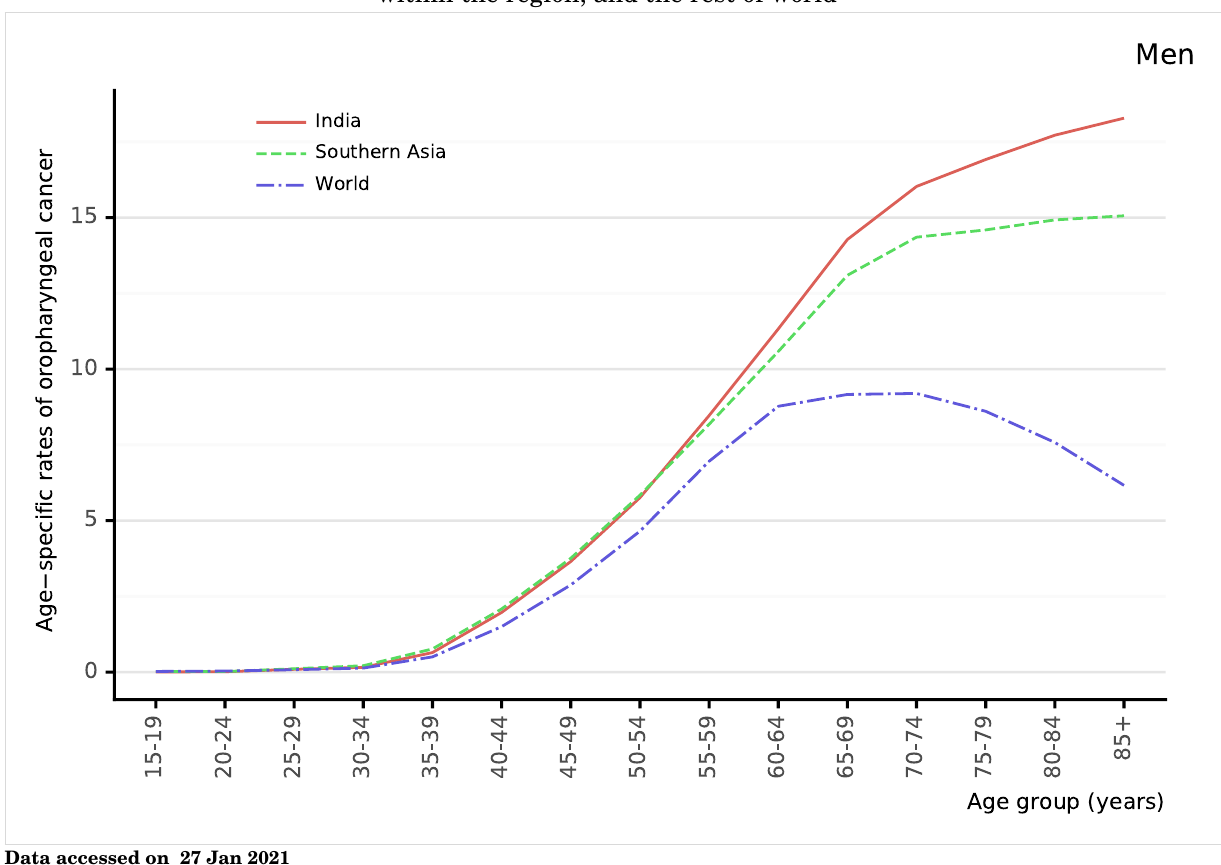
Figure 93: Comparison of age-specific oropharyngeal cancer incidence rates among men by age in India, within the region, and the rest of